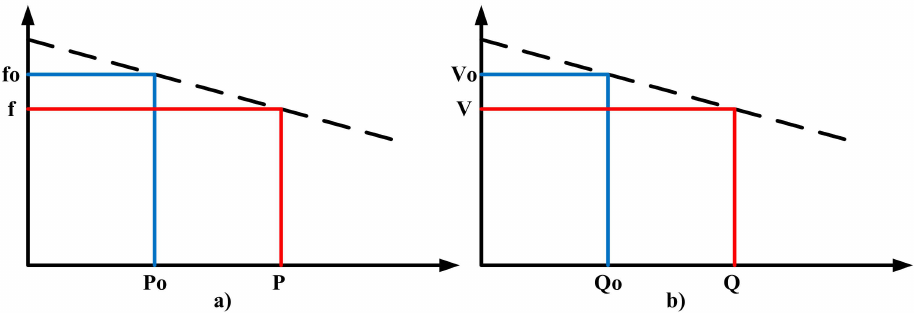
Figure 6. ( a ) Frequency reducing characteristic. ( b ) Voltage reducing